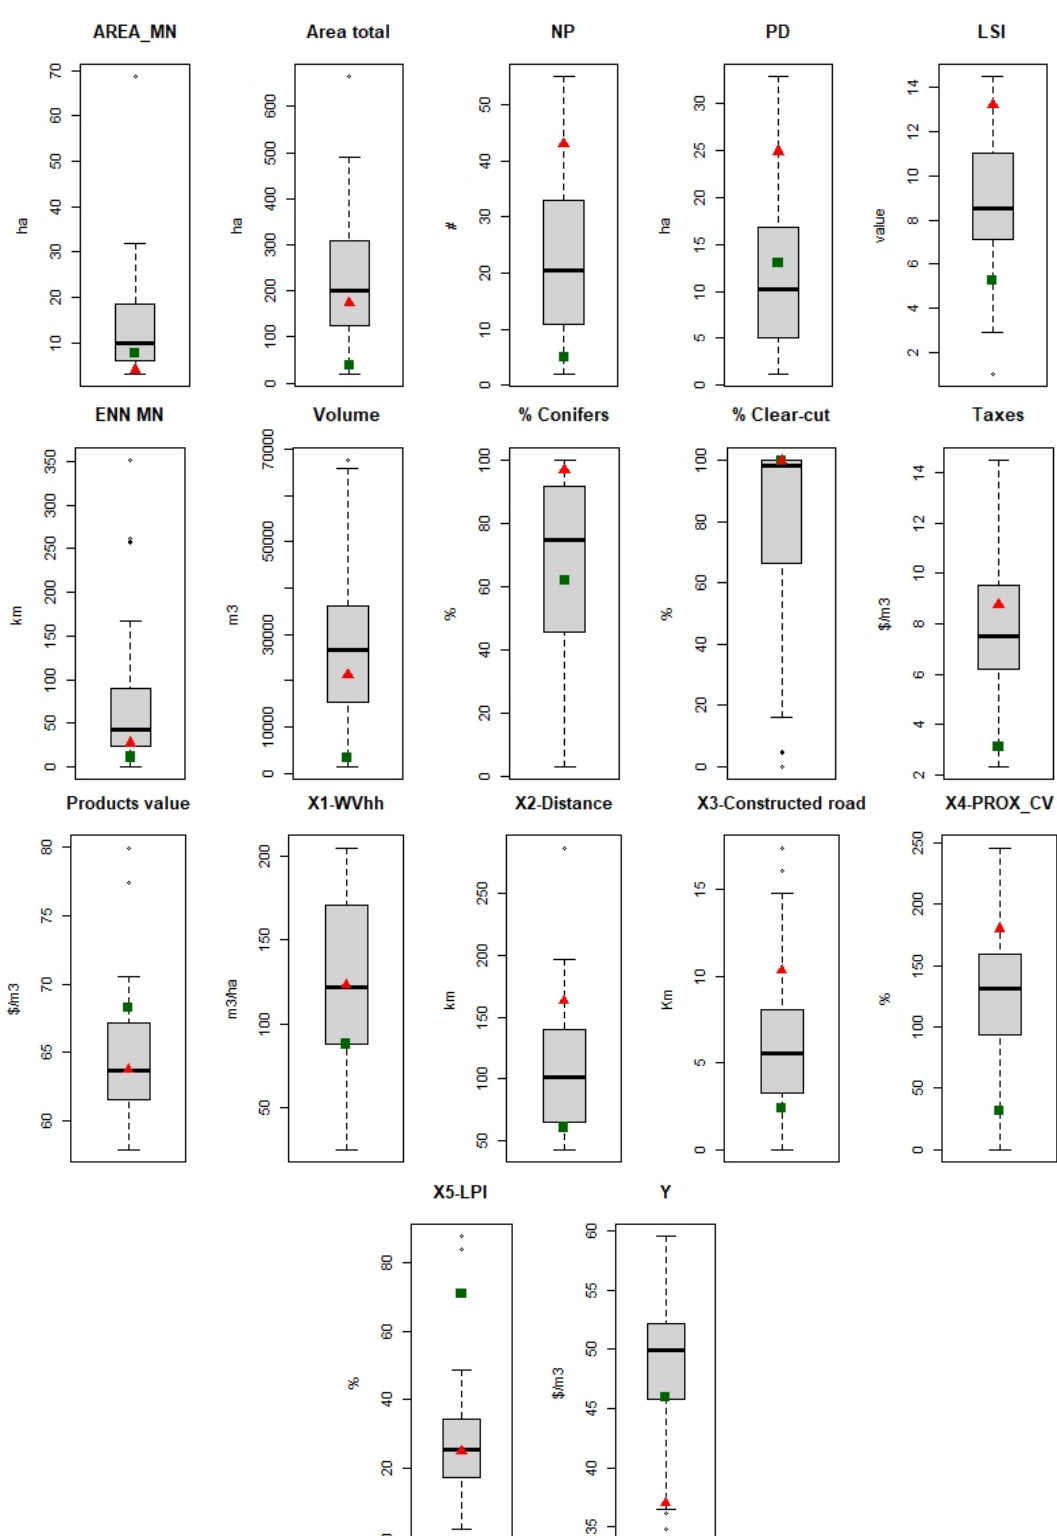
Figure 2. Box plots of some of the most representative variables for the 50 DMUs (for more details, see Table 1). The example from Figure 1 is presented showing red triangles for the dispersed DMUs (Figure 1A) and green squares for the agglomerated DMUs (Figure